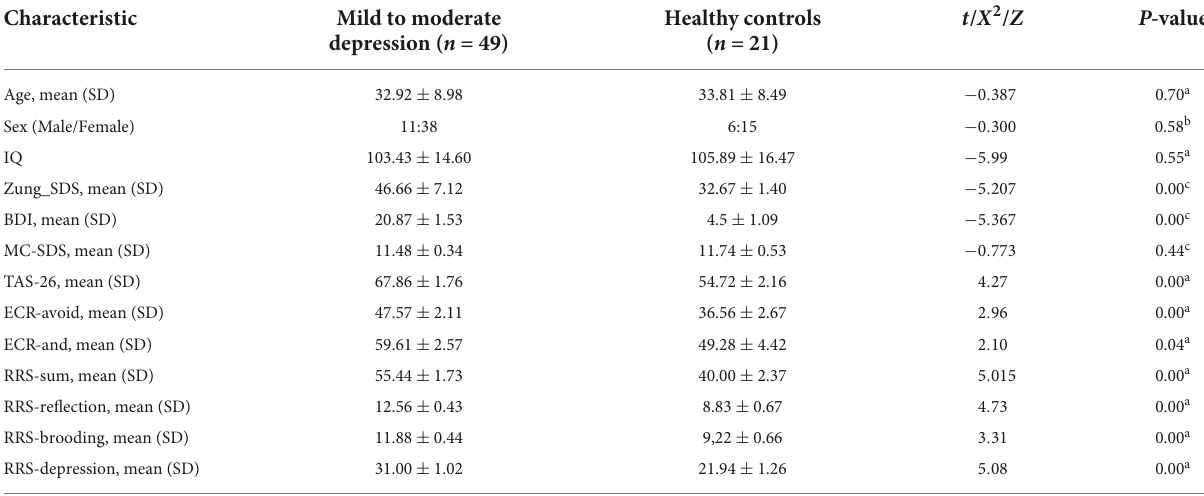
TABLE 1 Demographics and clinical